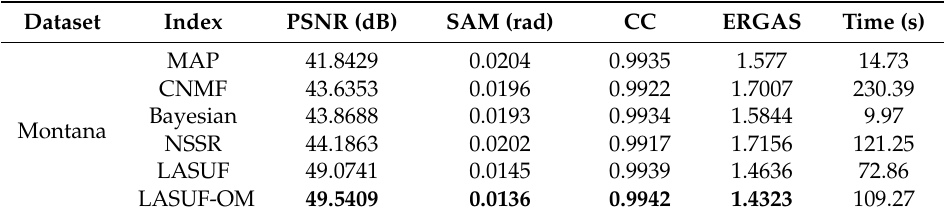
Table 3. Comparison of average statistical indexes of different methods of Montana data.